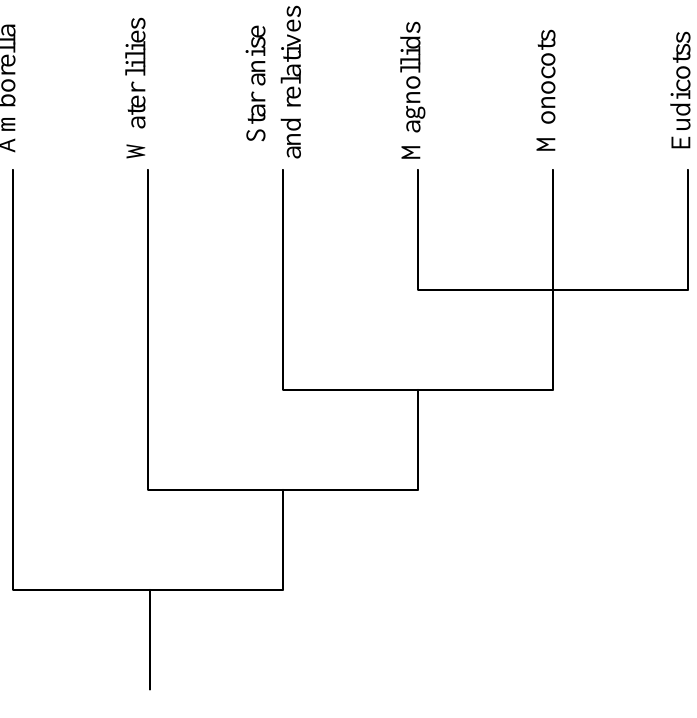
FIGURE 1 . Phylogeny of